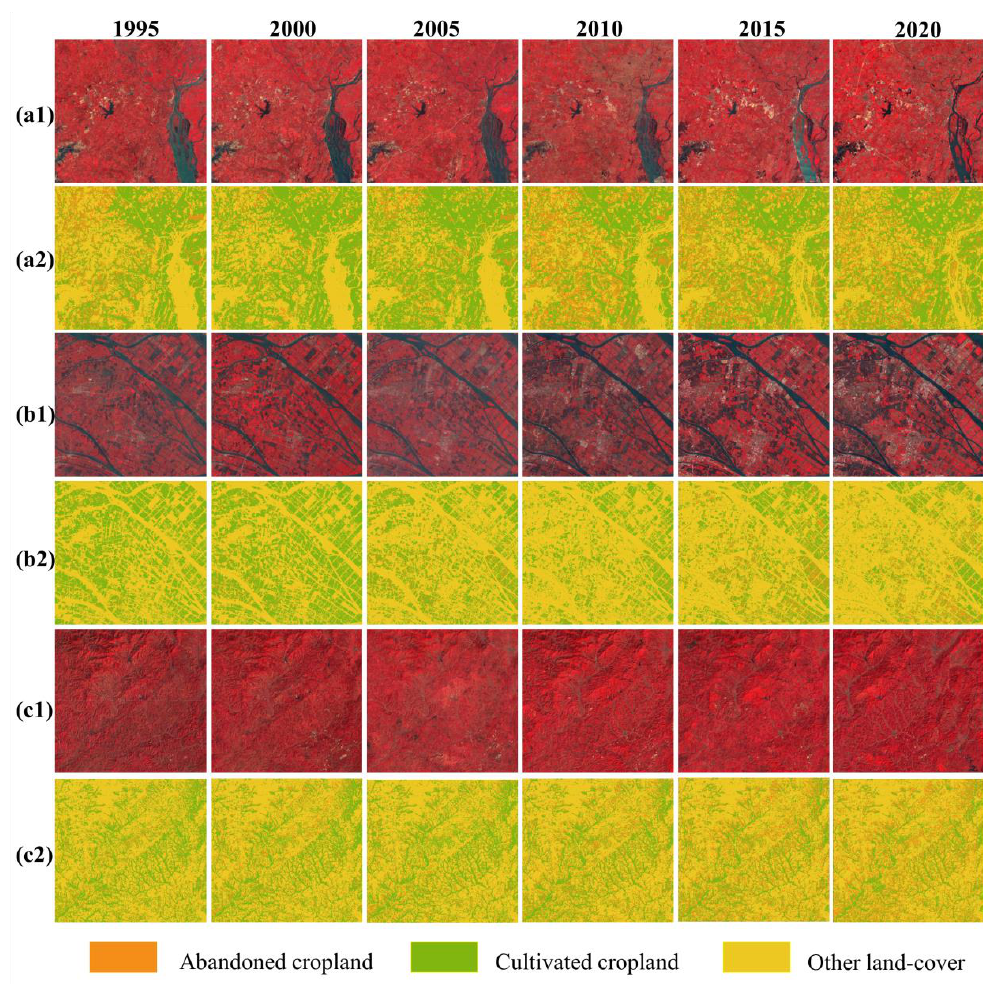
Figure 13. Examples of cropland abandonment maps in the plain areas ( a1 , a2 ): [110.5304, 21.3454], Figure 13.